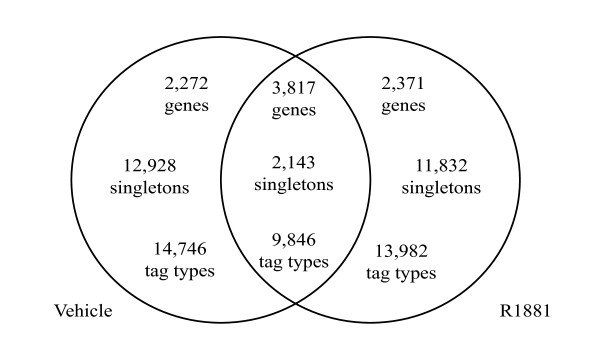
Relationship between LongSAGE library compositions. The Venn Diagram shows the tag types and genes exclusive to, and shared by each LongSAGE library, R1881 and vehicle. Tags were mapped unambiguously sense to RefSeq transcripts and redundant mappings were removed. Singletons are tags counted only once in each library, but may be common to both libraries.